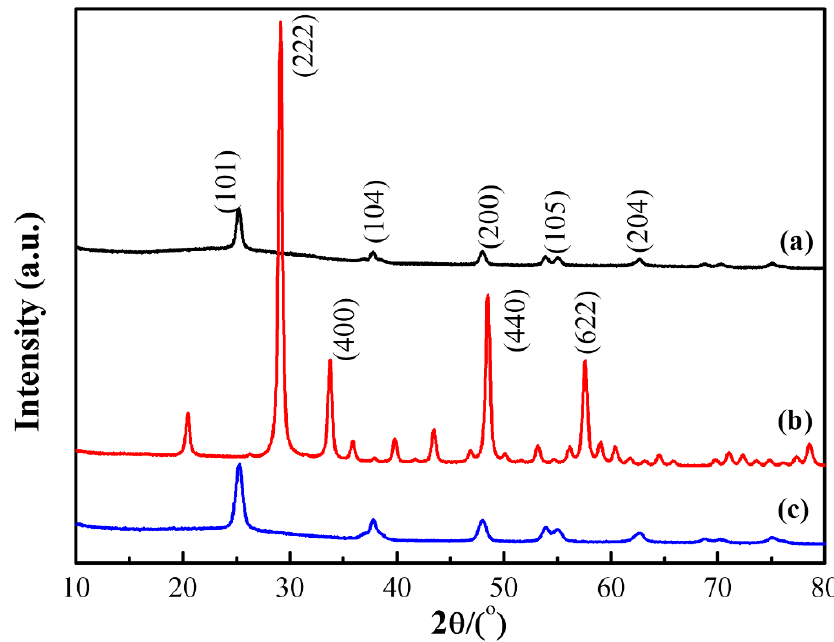
Figure 6. X-ray diffraction pattern of the photocatalyst ( a ) TiO 2 , ( b ) Y 2 O 3 , and ( c ) Y 2 O 3 /TiO 2 .